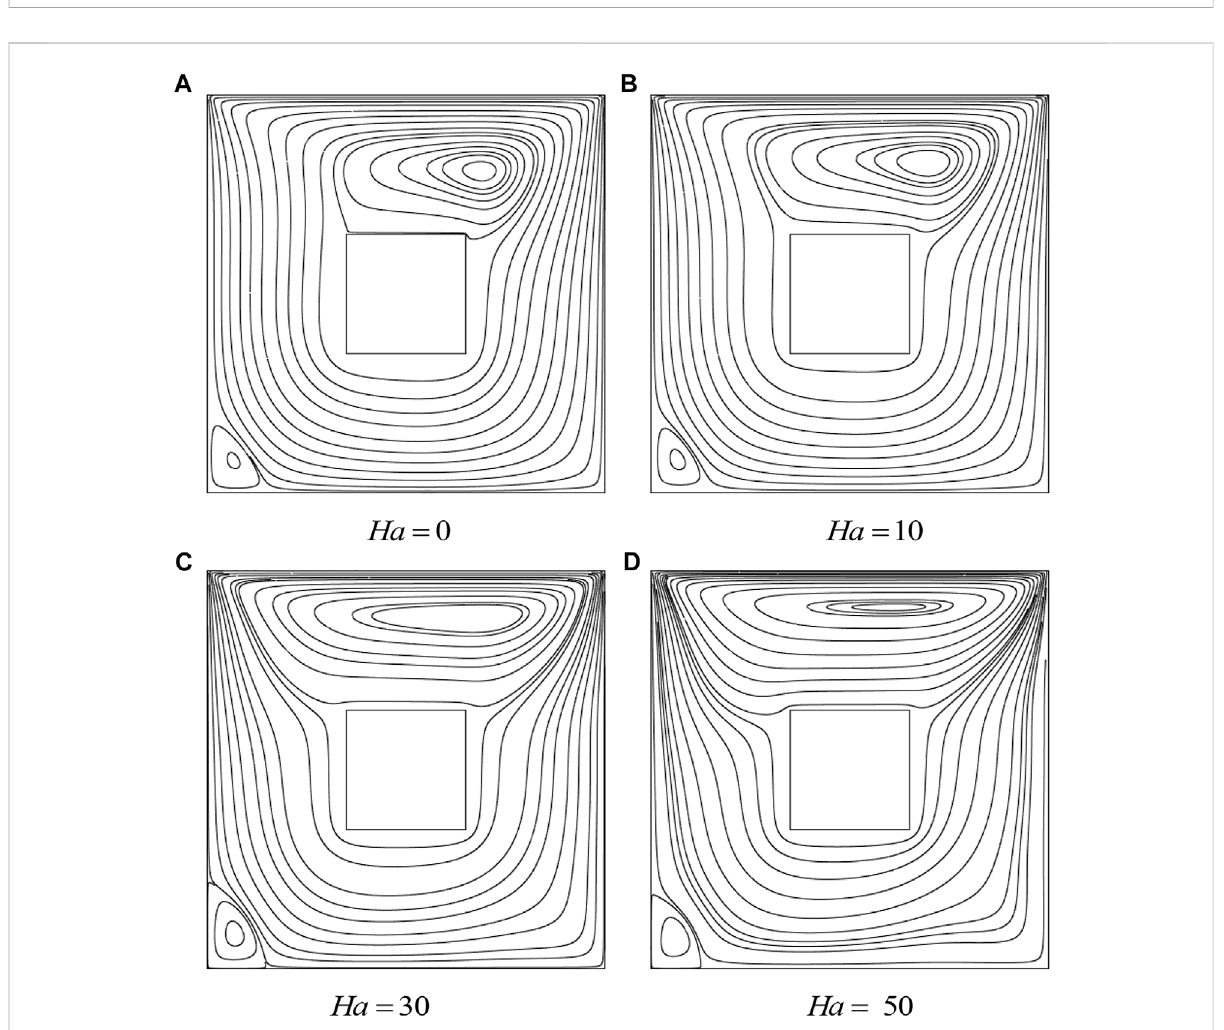
FIGURE 8 In fl uence of Ha on streamlines with a uniformly heated bottom wall: cold cylinder, Re (cid:2) 100 and Gr (cid:2) 10 4